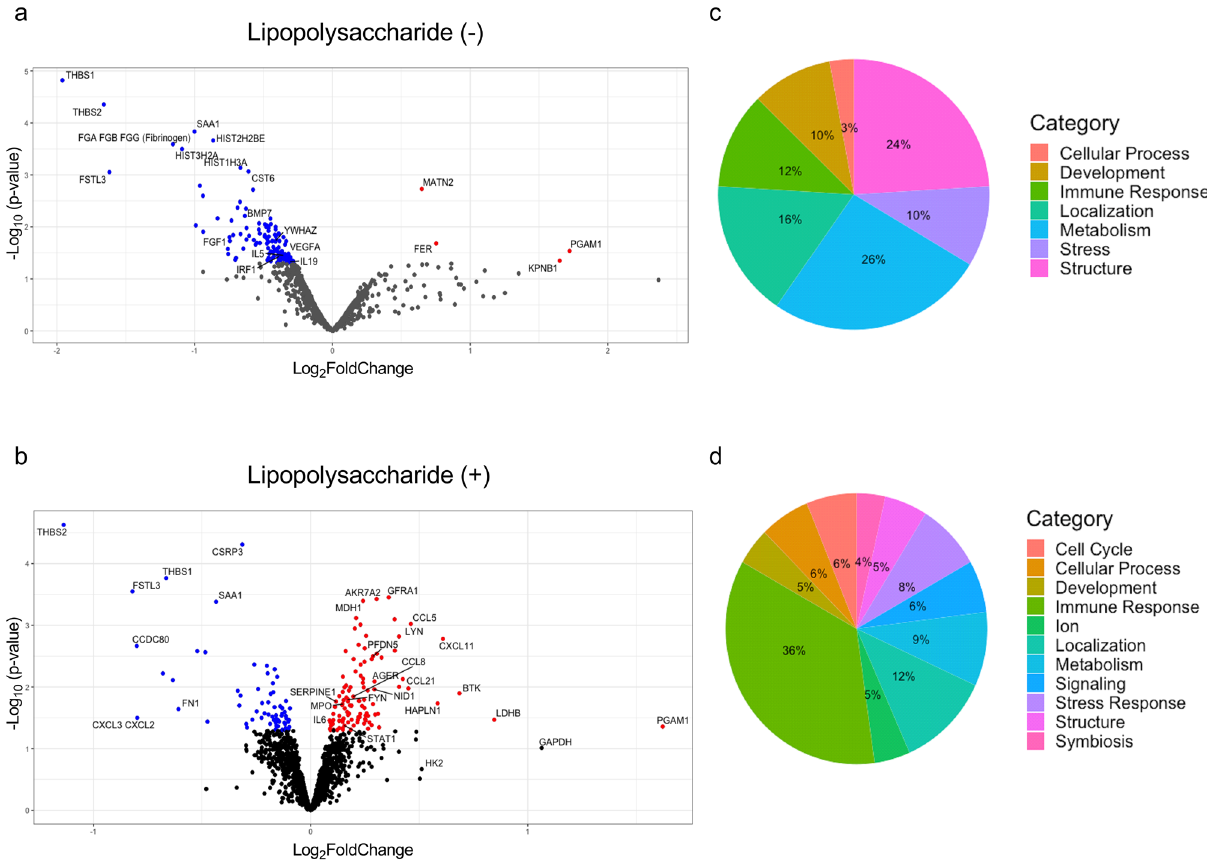
Figure 1. Regional proteomics and processes in the absence or presence of LPS. ( a ) Volcano plot for the condition of LPS(−) showing proteins mostly had less abundance in atelectatic than in aerated lung. ( b ) Volcano plot for the condition of LPS(+) presenting mostly increased proteins in atelectasis. Red dots represent significant proteins with increased fold-change in atelectasis compared to aerated lung; and blue for significant proteins decreased in atelectasis. ( c , d ) Categorical breakdown of processes in conditions of LPS(−) ( c ) or LPS(+) ( d ). LPS